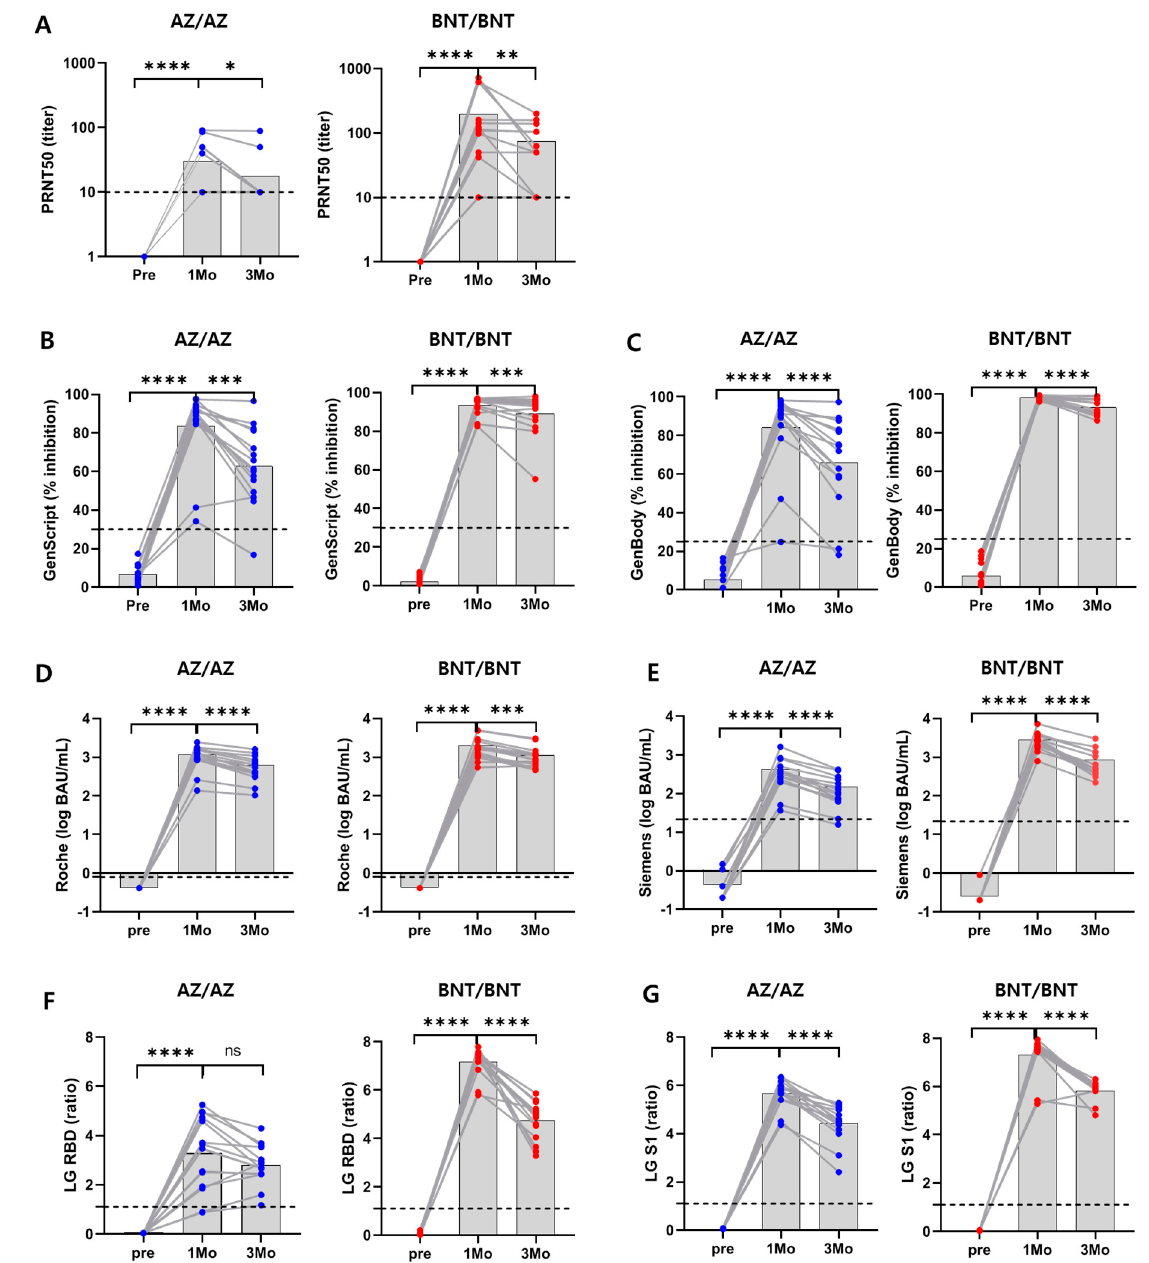
Figure 1. Anti-S1/RBD antibody and neutralizing antibody results for healthy donors after AZ/AZ or BNT/BNT vaccination. (A) Neutralizing antibody titers (PRNT); (B) ACE2-RBD inhibition by sVNT (GenScript); (C) ACE2-RBD inhibition (%) by sVNT (GenBody); (D) Anti-SARS-CoV-2 S RBD total Ig (log BAU/mL) (Roche); (E) SARS-CoV-2 S1 RBD IgG (log BAU/mL) (Siemens); (F) SARS-CoV-2 RBD IgG (ratio) (RBD) (LG RBD); (G) SARS-CoV-2 S1 IgG (ratio) (LG S1). Paired antibody courses at 1 month and 3 months post second dose are shown. Gray bars indicate median values. * p < 0.05; ** p < 0.01; *** p < 0.001; **** p < 0.0001 by Wilcoxon signed-rank test for paired samples.